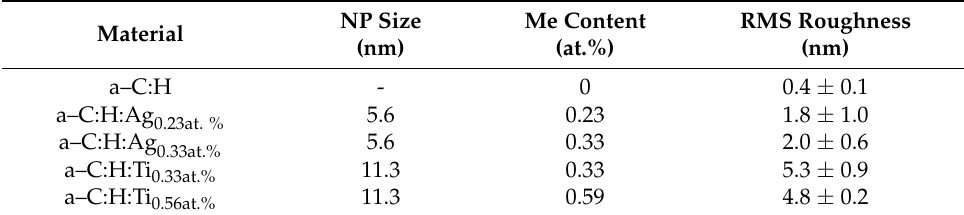
Table 3. Deposition details of the nanocomposite films grown in this study and the resulting surface roughness as quantified through AFM. PVD conditions: Argon flow, magnetron position, and sputtering current were set at 60 sccm, 8.5 cm and 60 mA. PECVD conditions: 6 sccm/0.5 sccm (CH 4 /Ar), 200W RF power and 150 V grid current. The Me content is calculated through the calibration curve presented in Figure 5 and the measured NP size and a–C:H deposition rate.